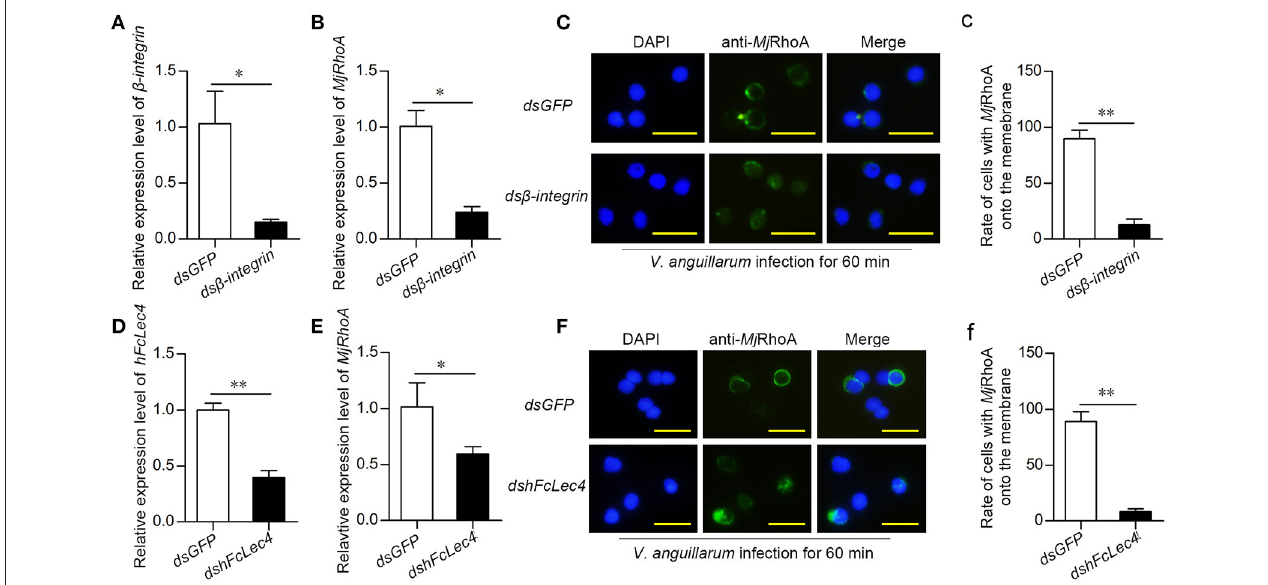
FIGURE 5 | Mj RhoA participates in hFcLec4- β -integrin-mediated phagocytosis. (A) The knockdown efficiency after injection of β -integrin dsRNA. Shrimp injected with the same amount of dsGFP (30 µ g per shrimp) were used as a control. (B) MjRhoA expression detection after knockdown of β -integrin ; dsGFP was used as a control. (C) The subcellular location of Mj RhoA analysis by immunocytochemistry assay after knockdown of ds β -integrin . Normal shrimp were first injected with 30 µ g β -integrin dsRNA for 48h and then injected with V. anguillarum (10 7 cells per shrimp) for 1h. The location of Mj RhoA in dsGFP -injected shrimp hemocytes was used as a control. Scale bar = 20 µ m. (c) The statistical analysis of the cells with Mj RhoA located on the membrane after injection of ds β -integrin ; at least three different views were chosen for cell counting; dsGFP injection was used as a control. (D) The knockdown efficiency of hFcLec4 . Injection of dsGFP was used as a control. (E) The MjRhoA expression level analyzed by qPCR after knockdown of hFcLec4; dsGFP was used as a control. (F) The subcellular location of Mj RhoA after knockdown of hFcLec4 ; dsGFP was used as a control. (f) Rate of cells with Mj RhoA transferred to the cell membrane after knockdown of hFcLec4 . * p < 0.05, ** p <